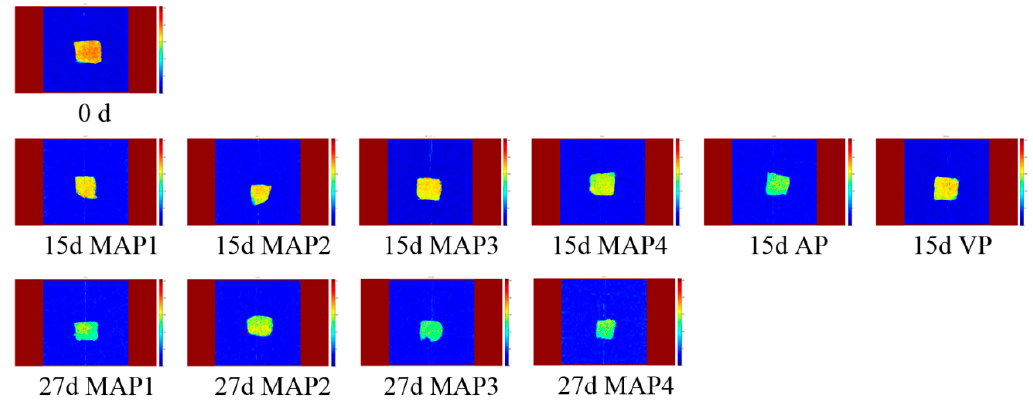
Figure 3. Results of magnetic resonance imaging (MRI) of samples under different treatments during storage period (AP: air packing; VP: vacuum packing; MAP1:70% CO 2 /30% N 2 ; MAP2: 60% CO 2 /10% O 2 /30% N 2 ; MAP3: 50% CO 2 /15% O 2 /35% N 2 ; MAP4: 55% CO 2 /5% O 2 /40% N 2 ).